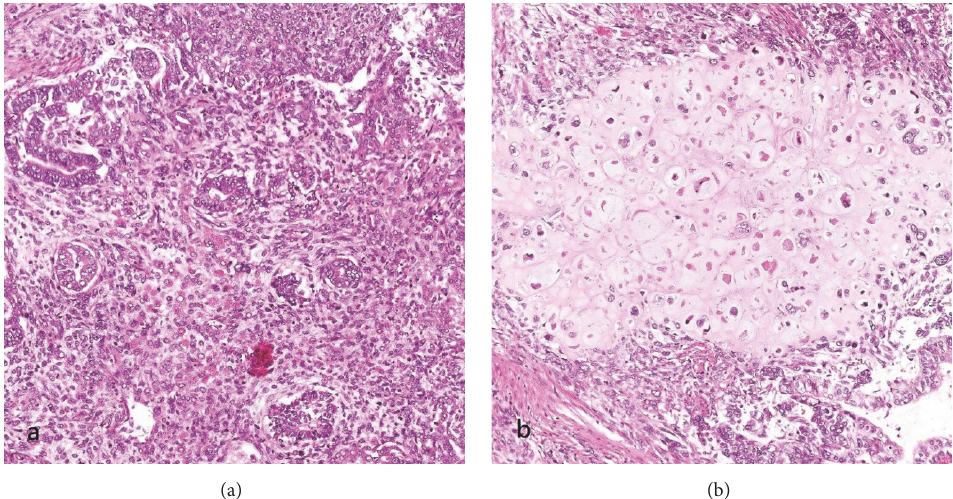
Figure 4: (a) Endometrioid adenocarcinoma components (H&E); (b) chondrosarcomato id components (H&E).